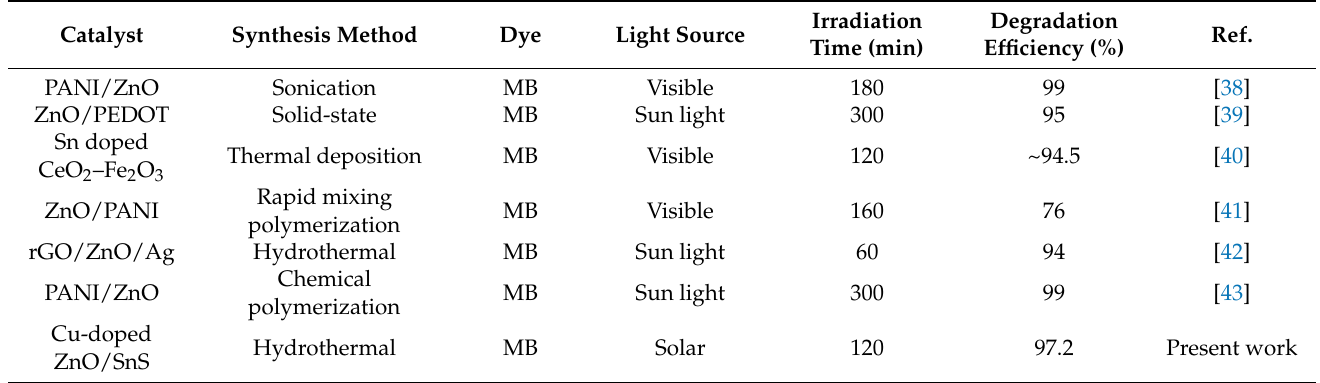
Table 2. Comparison of the photocatalytic efficiencies of various ZnO-based nanocomposites in the degradation of methylene blue